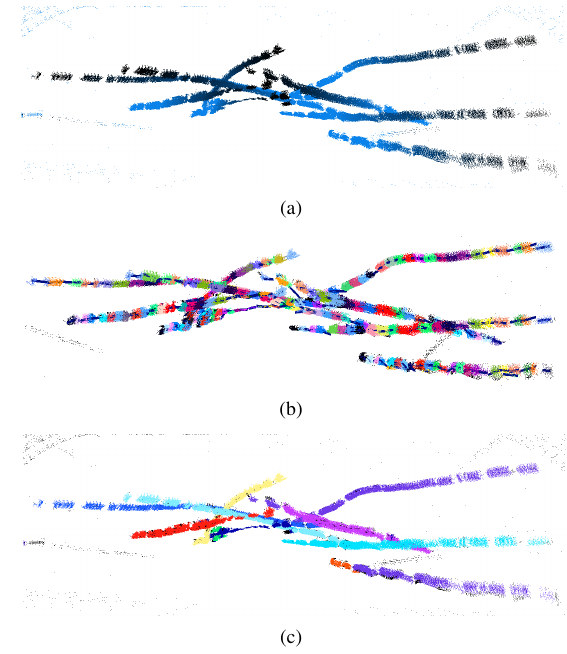
Figure 5: Moving object tracking. (a) original detected mov- ing points; (b) detected tracklets in partitioned temporal windows (tracklets are in dark blue, points in different temporal windows are coloured randomly); (c) connected final trajectories.